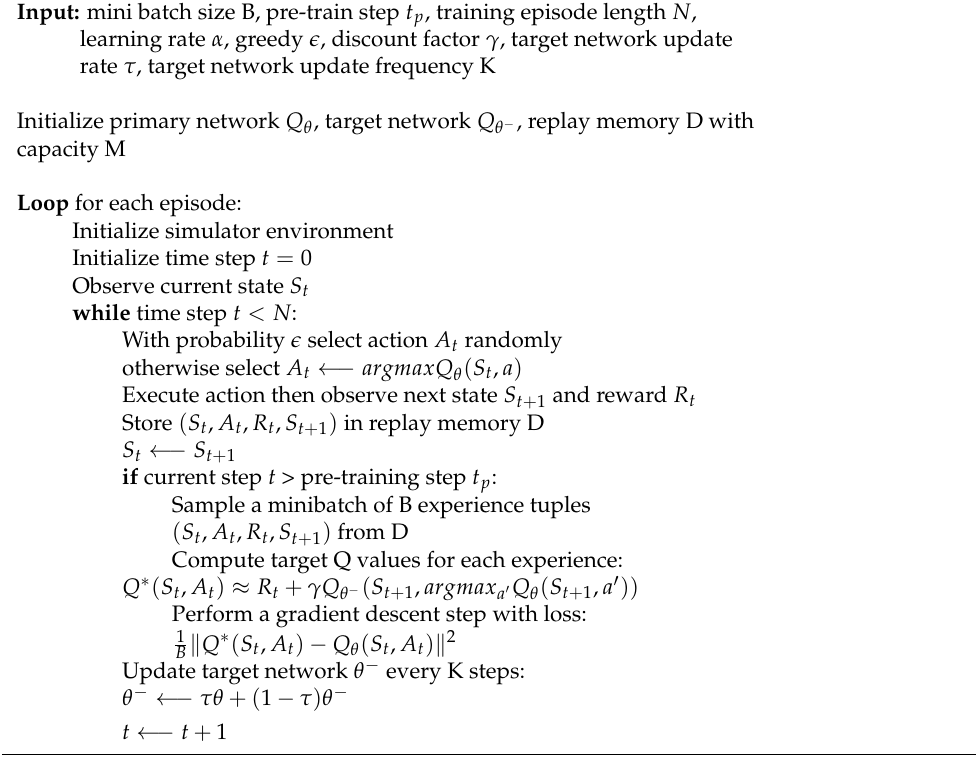
Algorithm 1: Pseudo-code for training algorithm of DRL-based